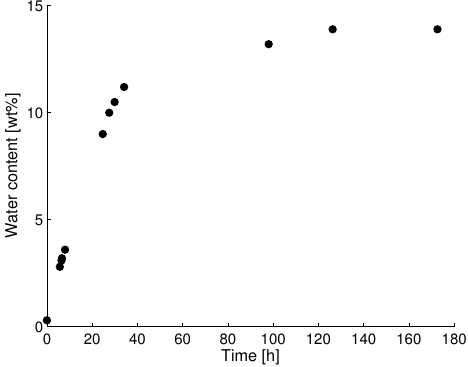
Figure 5. Water content increase in [Choline] [Proline] at relative humidity of